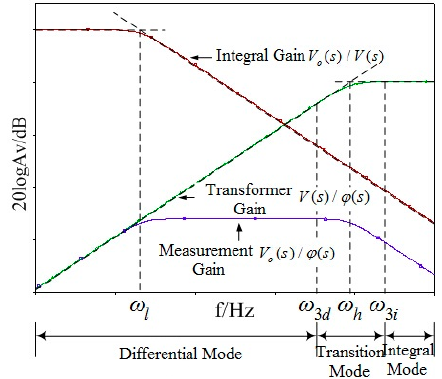
Figure 7. Amplitude-frequency response curve.